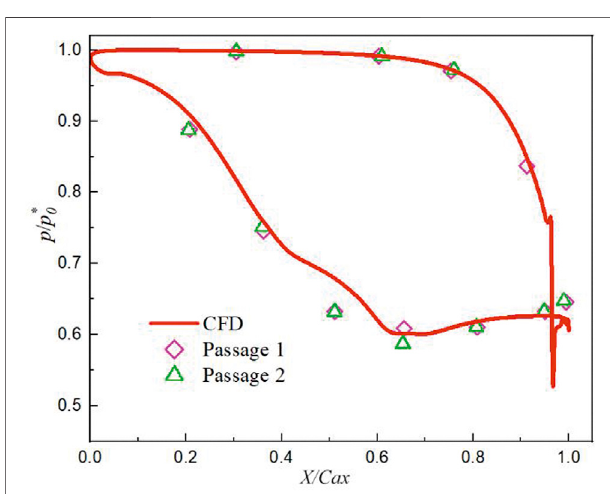
FIGURE 3 | Comparison of numerical result with experimental data.